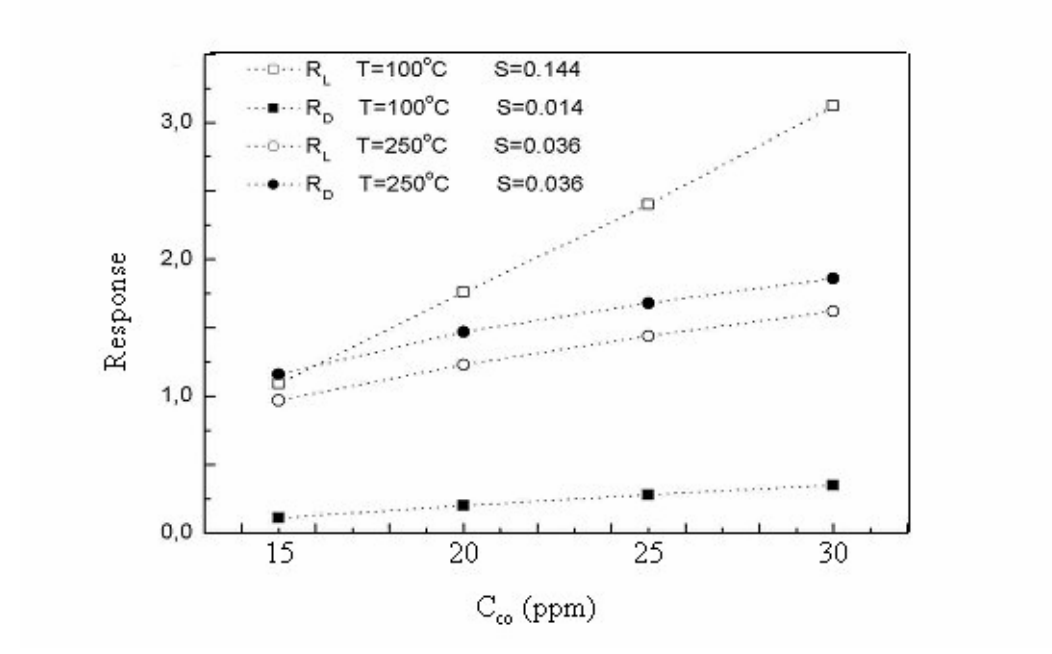
Figure 7. Response with light (15 mW/mm 2 ) and in dark conditions as a function of CO concentration and sensitivity, S = δ R / δ C